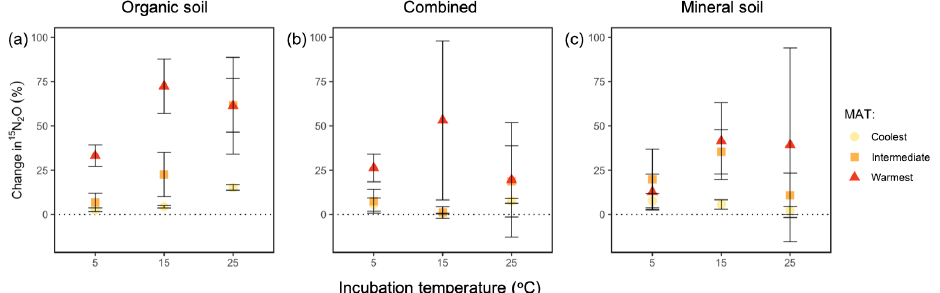
Figure 5. Change in the percentage of added 15 N observed in the headspace N 2 O over the course of a 60h incubation at 5, 15, and 25 ◦ C ( t 60h − t 3h ) for organic (a) , combined organic and mineral (b) , and mineral (c) soils from three regions along a boreal forest latitudinal transect. “Combined” refers to incubations with organic and mineral soil in the same jar, which are physically isolated but share the headspace. “MAT” refers to the mean annual temperature. The “coolest” region is the Eagle River watershed (northern boreal), the “intermediate” region is the Salmon River watershed (mid-boreal), and the “warmest” region is the Grand Codroy watershed (southern boreal). See the text for site descriptions. Values are provided as the mean ± 1SE ( n = 3 forests per latitudinal